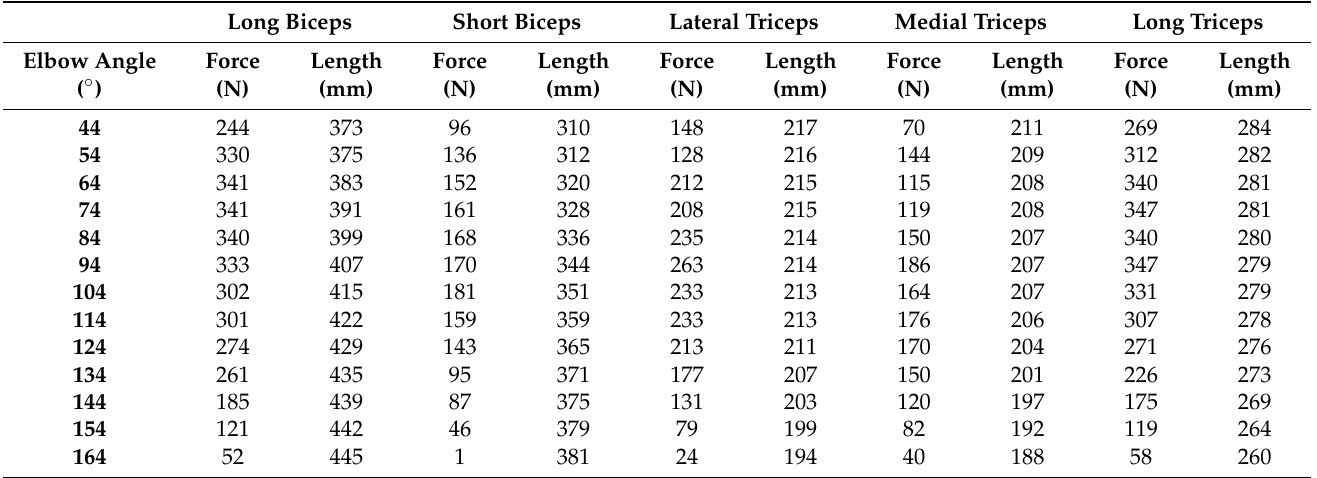
Table 2. Axial efforts (N) in main simulated muscles, 150 N applied on wrist. Isometric contractions at each angle value considered.